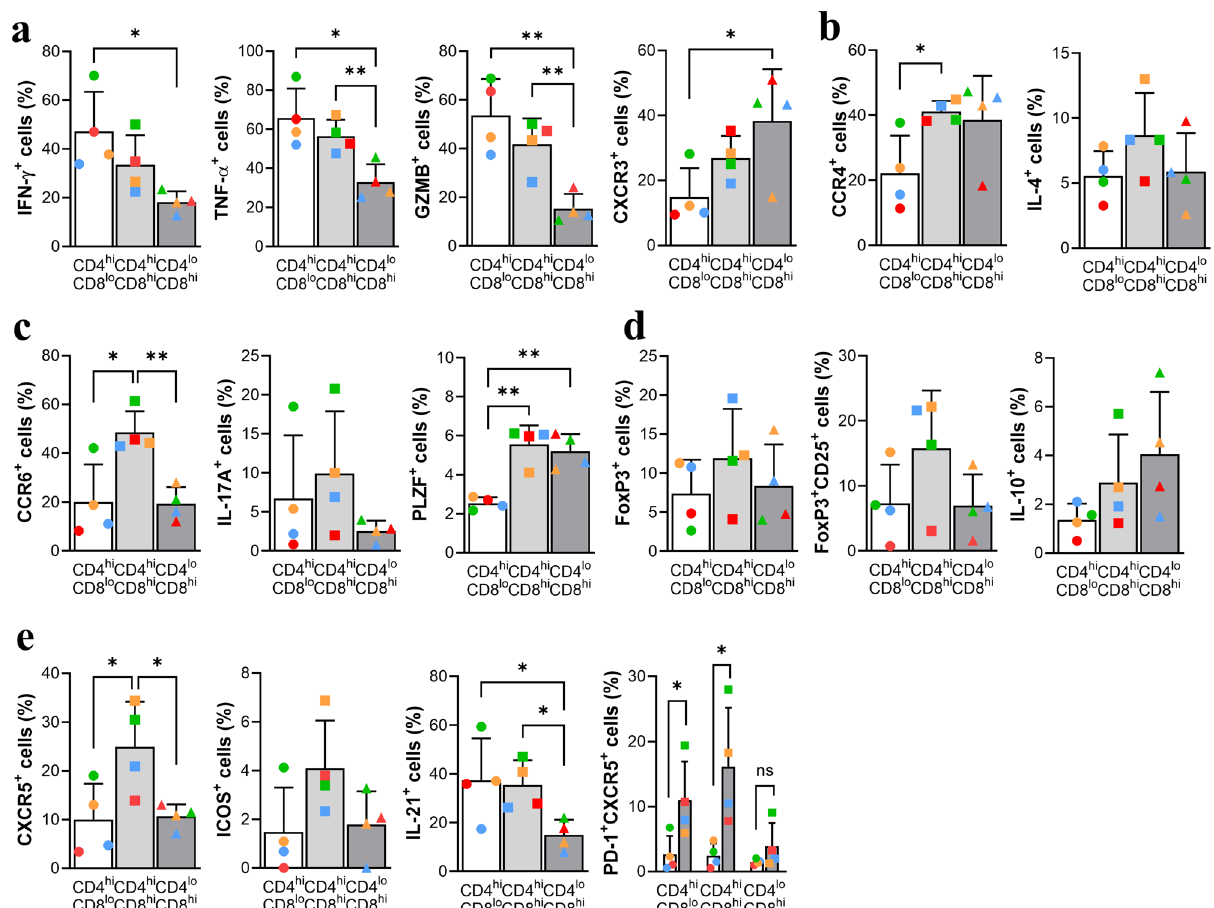
Figure 5. Phenotype and cytokine profile of the CD4 hi CD8 lo and CD4 hi CD8 hi fractions. ( a ) Percentage of cells expressing IFN-γ + , TNF-α + , Granzyme B + , and CXCR3 + within each DP T cell fraction. ( b ) Percentage of CCR4 + and IL-4 + cells within each DP T cell fraction. ( c ) Percentage of CCR6 + , IL-17A + , and PLZF + cells within each DP T cell fraction. ( d ) Percentage of FoxP3 + , FoxP3 + CD25 + , and IL-10 + cells within each DP T cell fraction. ( e ) Percentage of CXCR5 + , ICOS + , IL-21 + , and PD-1 + CXCR5 + cells before and after stimulation of PBMCs with plate-coated anti-CD3 2 μg/ml and soluble anti-CD28 2 μg/ml for 24 h. Cytokine production levels were measured after stimulation of PBMCs with PMA/ionomycin for 4 h. Data are expressed as the mean ± SDs (n = 4). Red dots on the bar graph represent data from the monkey used for scRNA-seq analysis. * p < 0.05; ** p < 0.01; ns not